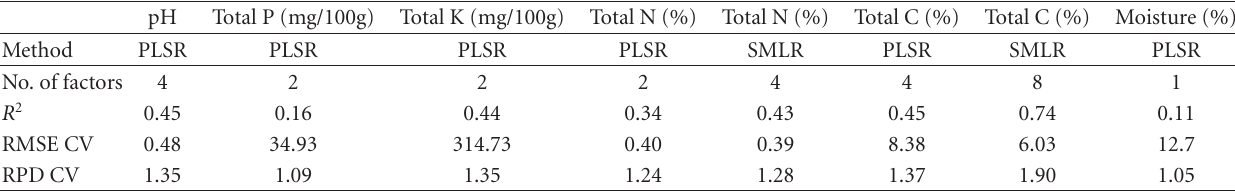
Table 3: Performance of model fits using spectra of samples under field conditions, evaluated with leave-one-out cross validation. pH Total P (mg/100g) Method